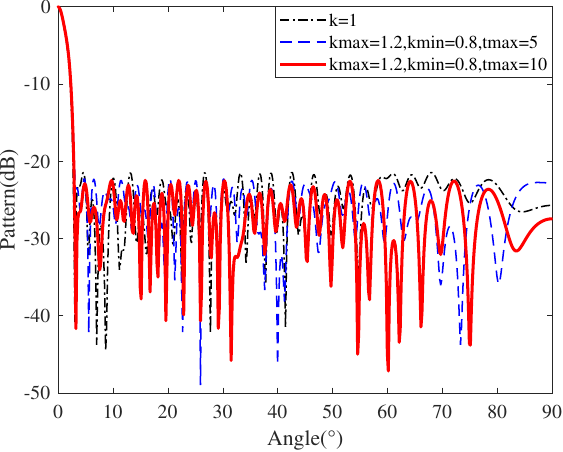
Figure 11. Beampatterns of off-grid arrays (40-element) under three sets of RL parameters.